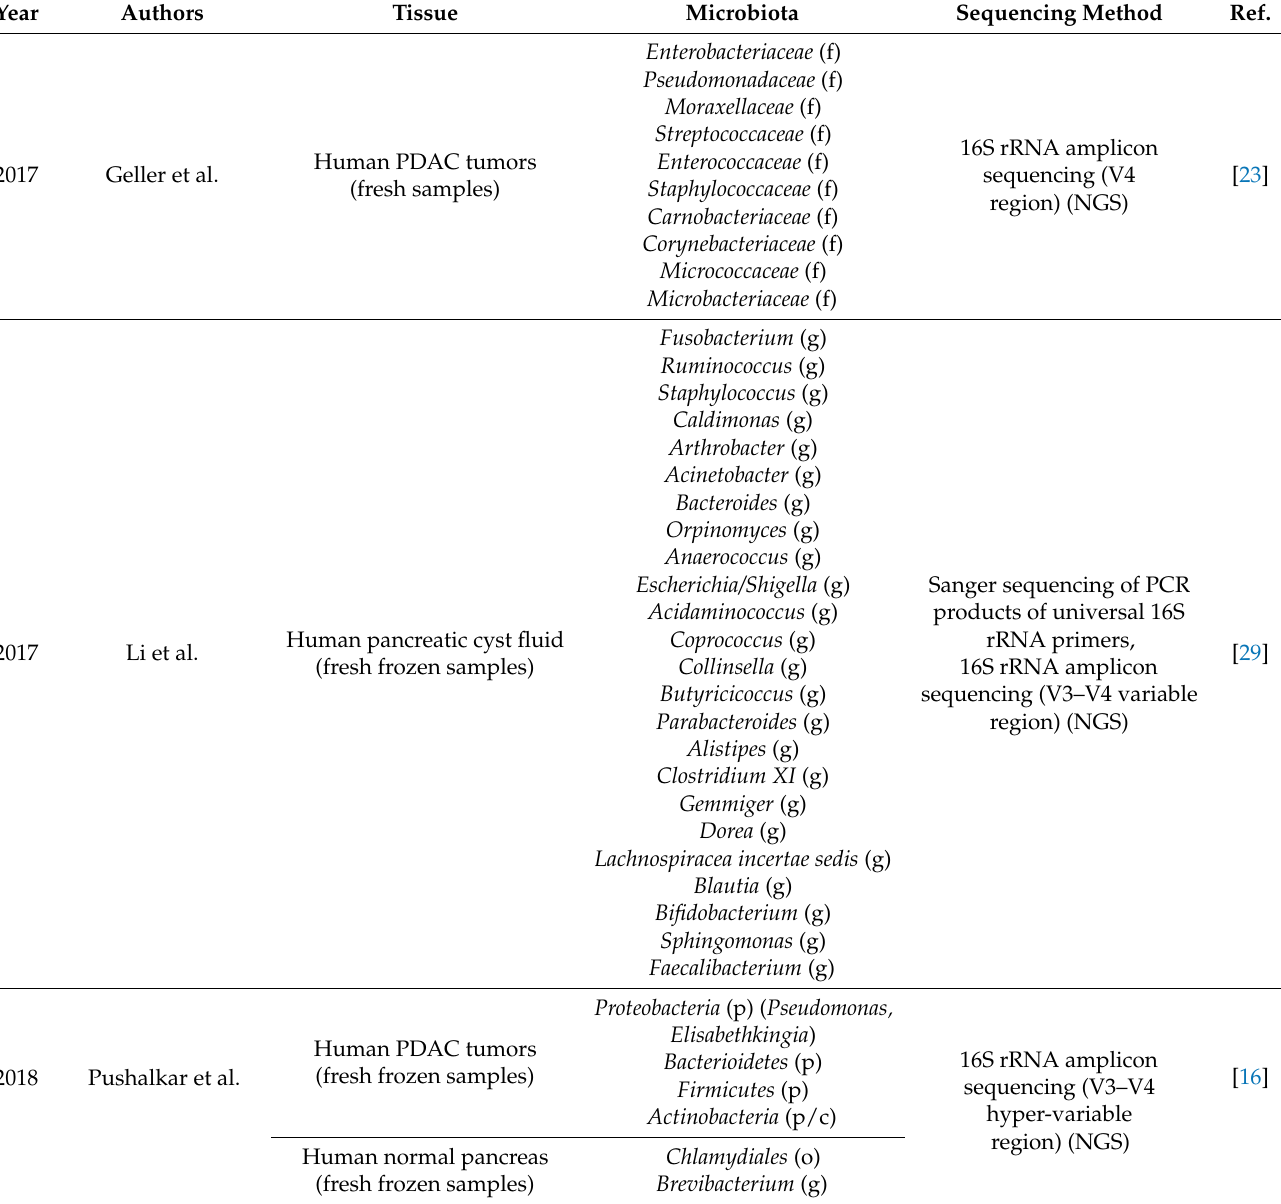
Table 1. Overview on pancreatic microbiota (including fungi) described in recent